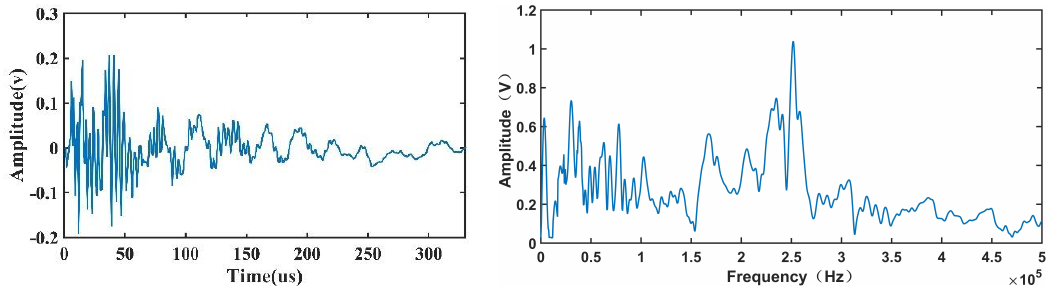
Figure 15: Typical waveform and FFT spectrogram for class3